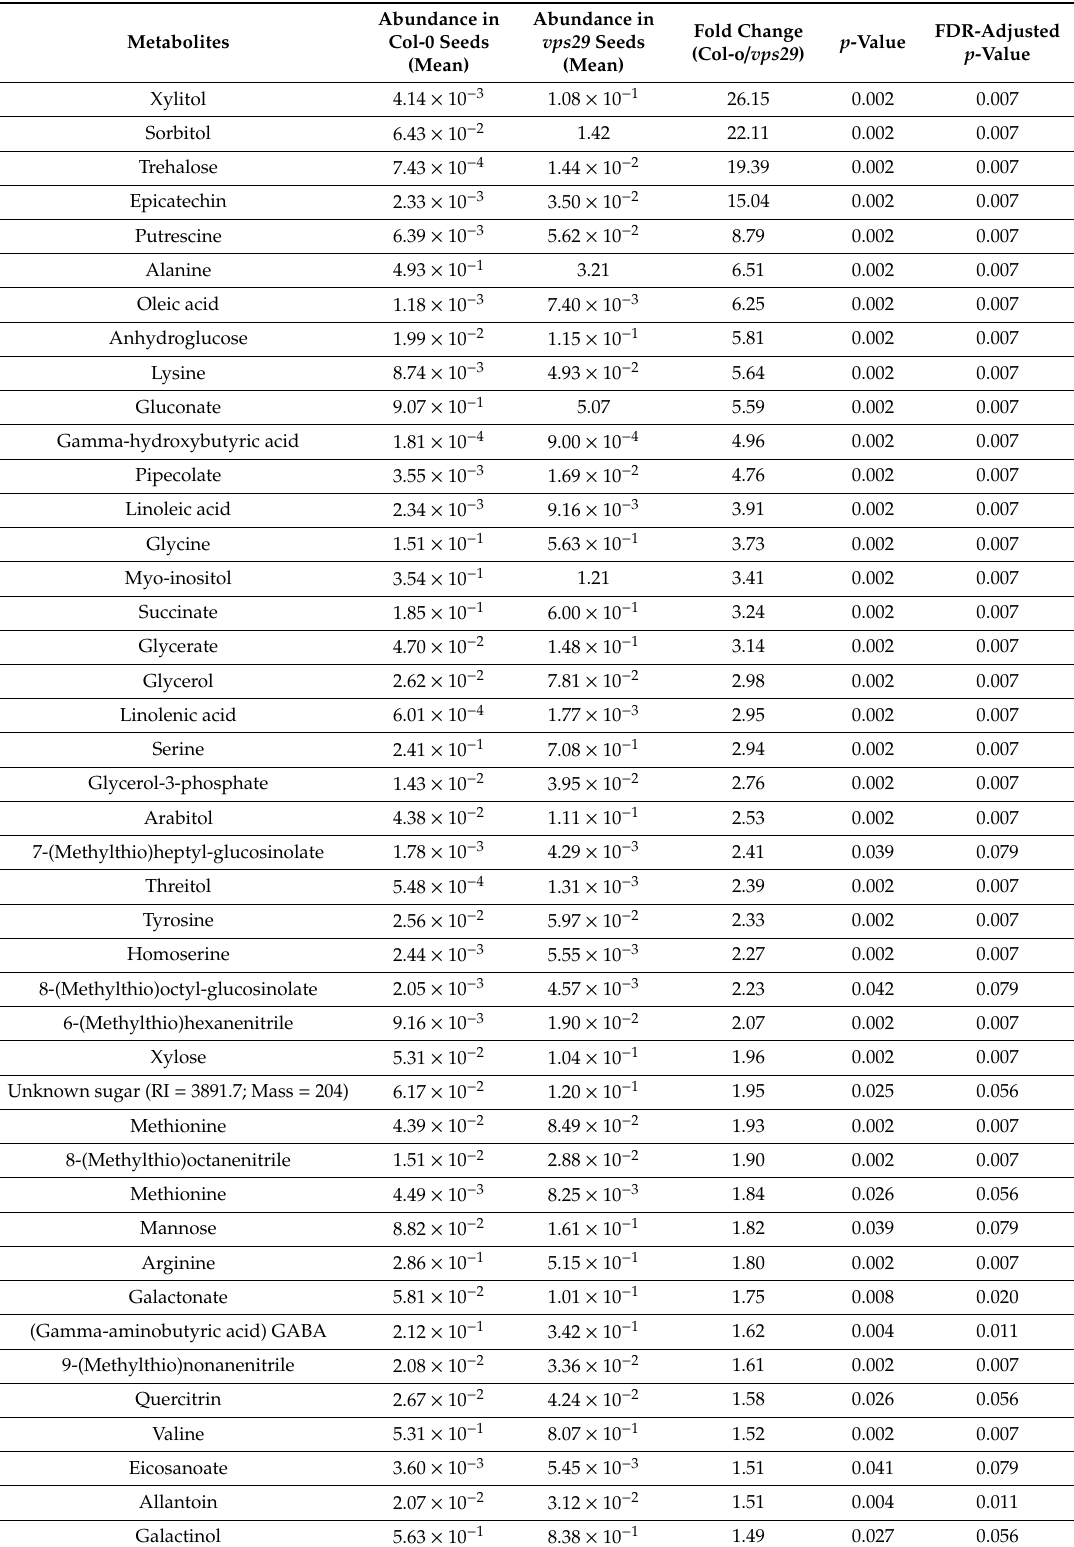
Table 2. Metabolites significantly up-accumulated in vps29 dry seeds by comparison with Col-0 dry seeds. A Kruskal–Wallis test and a Benjamini and Hochberg false discovery rate (FDR) adjustment were used with a significance level set at 5%. Significant p -values are indicated in bold. RI, retention index obtained from GC / MS analysis. Metabolites that were detected but with no significant change in abundance between genotypes are presented in the Supplementary Materials (Table